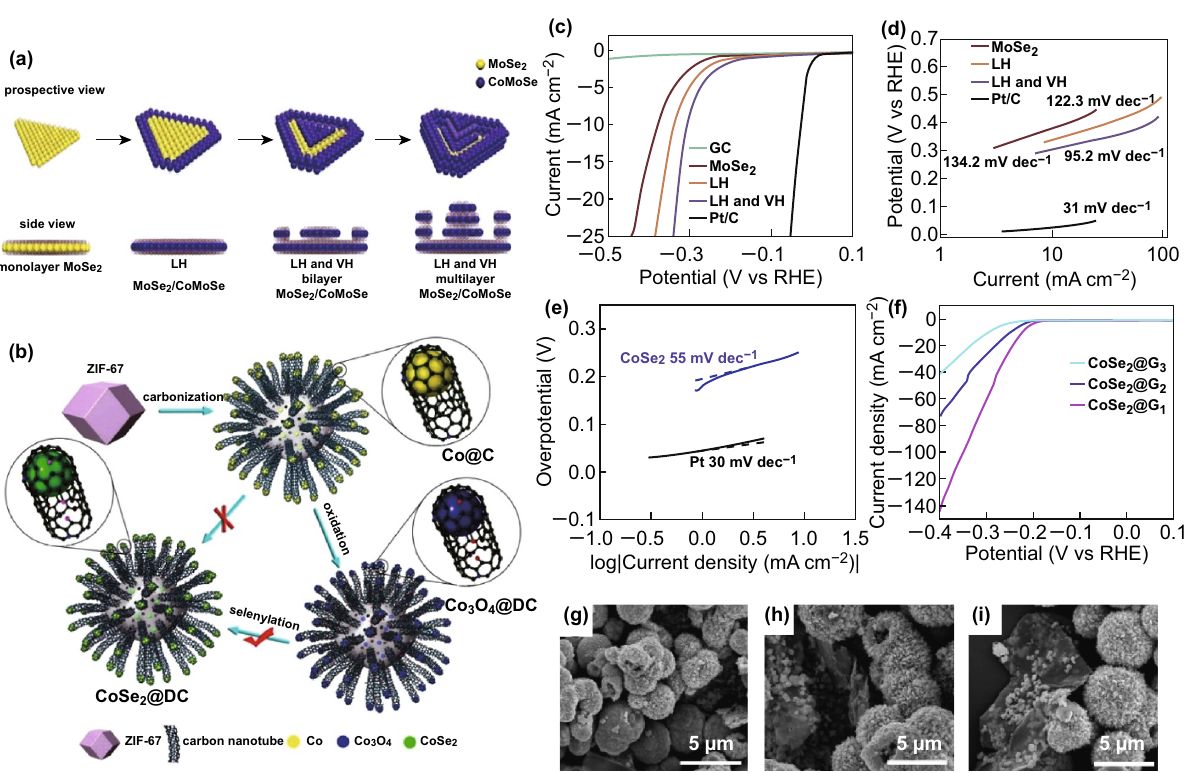
Fig. 13 a Schematic representation of the formation of defective 2D platform MoSe 2 /CoMoSe LH and LH and VH nanomolecules. b Schematic diagram of the synthesis process of CoSe 2 @DC. c Electrochemical catalytic performance of 2D triangular MoSe 2 monolayers, defective 2D platform MoSe 2 /CoMoSe LH, LH, and VH nanofilms on gas chromatographic electrodes. Polarization curve after infrared correction. d Elec- trochemical catalytic performance of 2D triangular MoSe 2 monolayers, defective 2D platform MoSe 2 /CoMoSe LH, LH and VH nanofilms on gas chromatographic electrodes. Tafel plot. e Corresponding Tafel slope of CoSe 2 and Pt. f Polarization curves of CoSe 2 @G 1 , CoSe 2 @G 2 , and CoSe 2 @G 3 . g FE-SEM image of CoSe 2 @G 1 . h FE-SEM image of CoSe 2 @G 2 . i FE-SEM image of CoSe 2 @G 3 . Adapted from [112–114] with permission. Copyrights: 2017, The Royal Society of Chemistry and 2016 (2017),